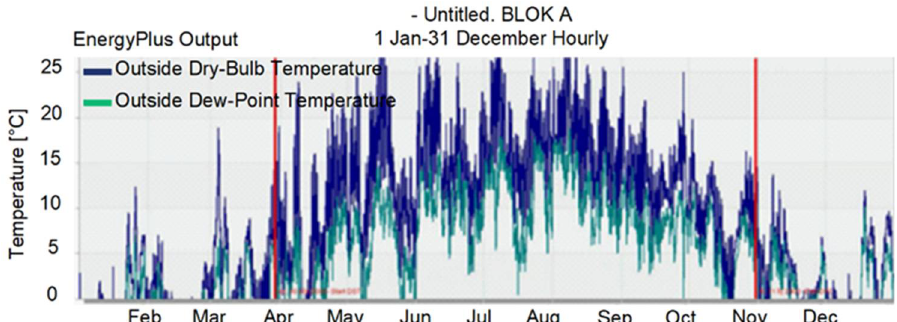
Figure 9. Outdoor temperatures in the solved locality throughout the year.